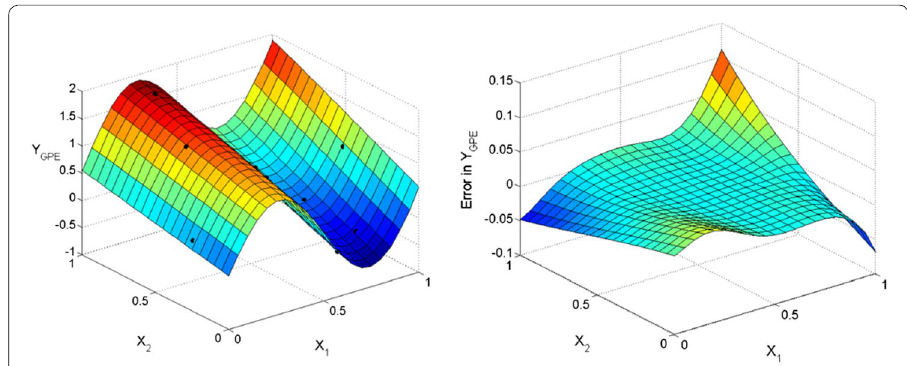
Fig. 4 An example of a Gaussian process surrogate model (left) and associated error estimate